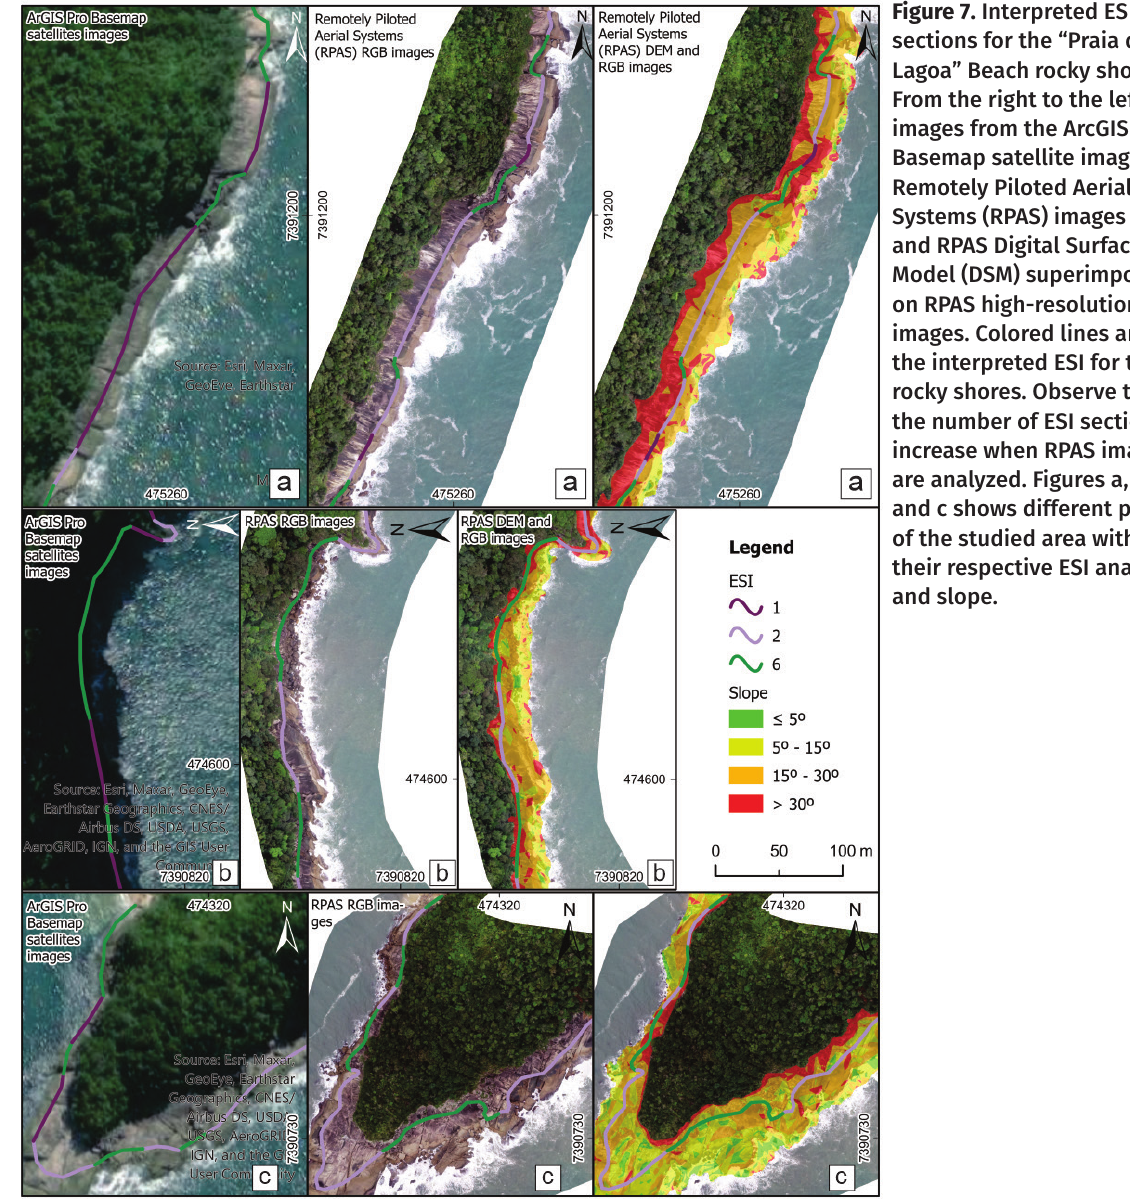
Figure 7 (“Praia da Lagoa” Beach rocky shore),